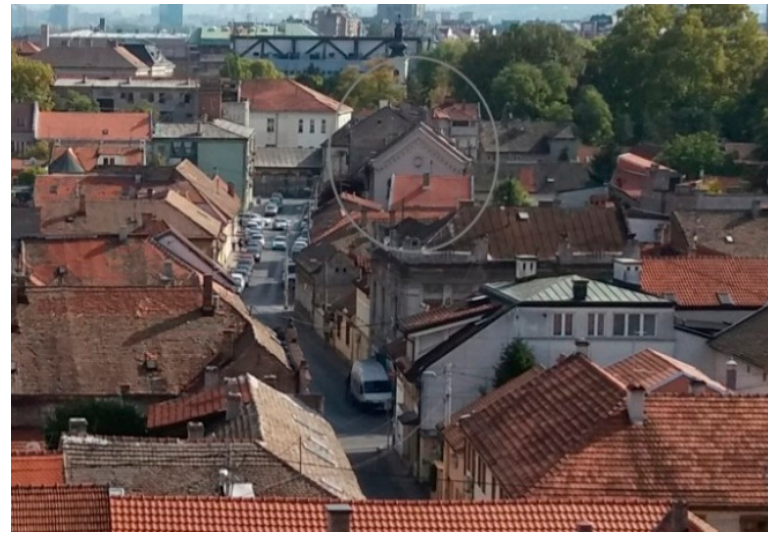
Figure 9. General view of Zemun Jewish quarter from Ć ukovac hill.